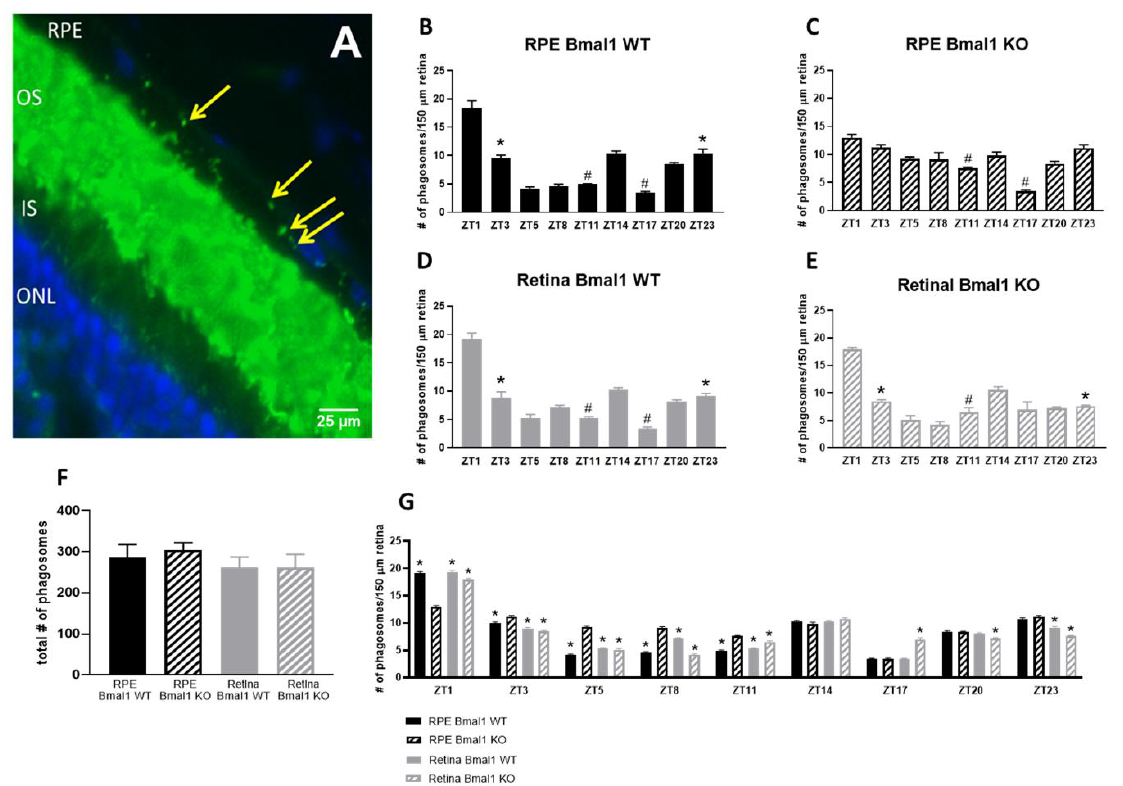
Figure 2. The RPE circadian clock controls the diurnal peak in phagocytosis of POS. One well known function of the RPE is its ability to phagocytose photoreceptor outer segments where a peak in phagocytic activity occurs 1–2 h after onset of light. We wanted to determine whether this function was under circadian regulation, so we used a conditional and inducible Bmal1 knockout in RPE cells. RPE Bmal1 WT, RPE Bmal1 KO, Retina Bmal1 WT, and Retinal Bmal1 KO mice were collected at the following time points: ZT1, ZT3, ZT5, ZT8, ZT11, ZT14, ZT17, ZT20, ZT23 with ZT0 at 7AM ( n = 4–6 eyes/genotype/time point). A representative microphotograph of a transverse eye section immunostained with anti-rhodopsin antibody (Rho4D2, green) and DAPI (blue) ( A ). Phagosomes (marked with yellow arrows) can be seen as small green particles present in the RPE cell layer (arrows). Bar graphs indicated the number of phagosomes per 150 µ m of RPE at different time points in four different genotypes ( B – E , G ). We then performed various phagocytic peak analyses to determine whether ablation of Bmal1 in the retina or RPE has any effect on the phagocytic capacity of RPE cells. The diurnal phagocytic peak at ZT1 was dampened in RPE Bmal1 KO mice ( C ) while maintained in RPE Bmal1 WT, Retina Bmal1 WT and Retinal Bmal1 KO mice when compared to ZT23 and ZT3 ( B , D , E ; * = p < 0.05, two-way ANOVA, Tukey post hoc). Interestingly, the nocturnal peak observed at ZT14 was maintained in RPE Bmal1 WT, RPE Bmal1 KO, and Retinal Bmal1 WT when compared to ZT11 and ZT17 ( B , C ; # = p < 0.05, two-way ANOVA, Tukey post hoc). However, this nocturnal peak was only partially observed in Retinal Bmal1 KO mice when compared to ZT11 ( E ; # = p < 0.05, two-way ANOVA, Tukey post hoc) and not ZT17 ( E ; p > 0.1, two-way ANOVA, Tukey post hoc). No